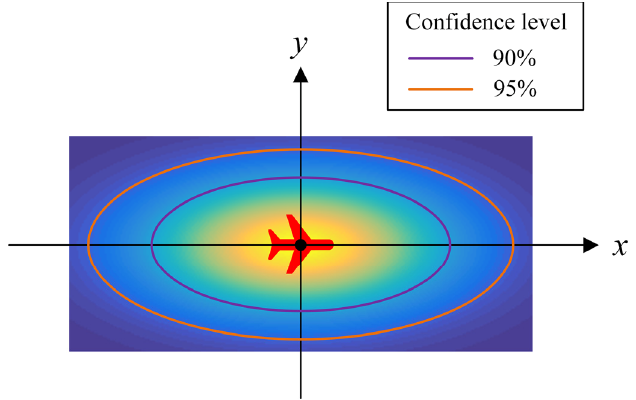
Figure 4. Real horizontal position obeys a two-dimensional Gaussian distribution.